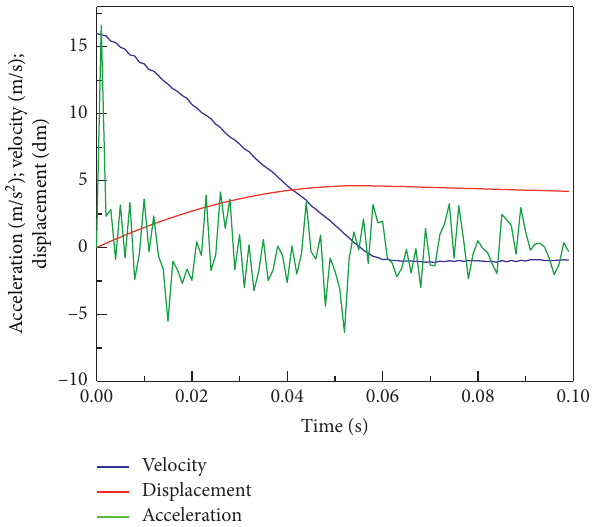
Figure 13: Results of the CLGAN model simulation.